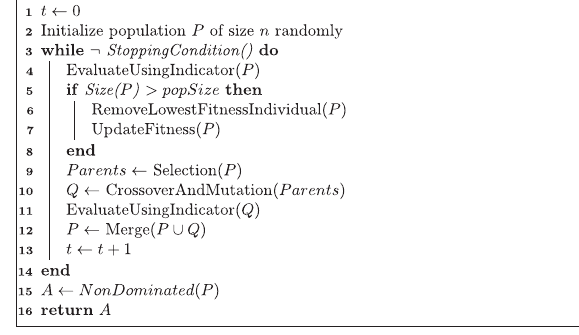
Figure 10: Pseudocode of